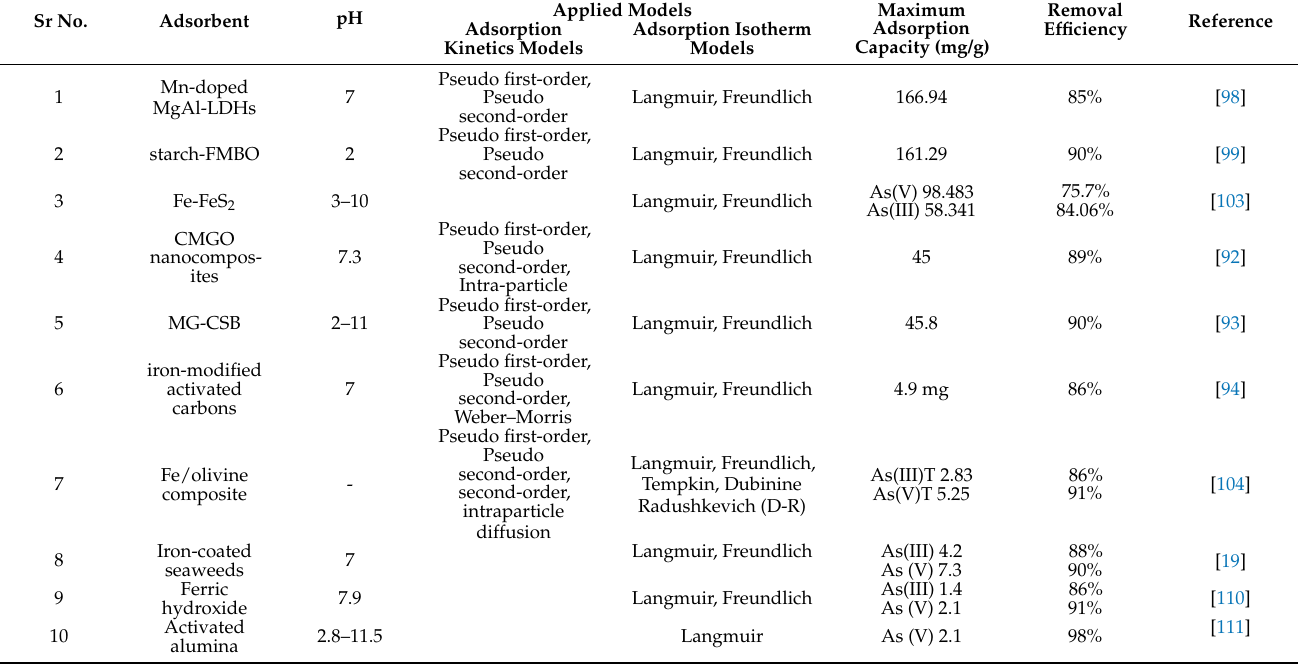
Table 5. Different adsorbents used for arsenic